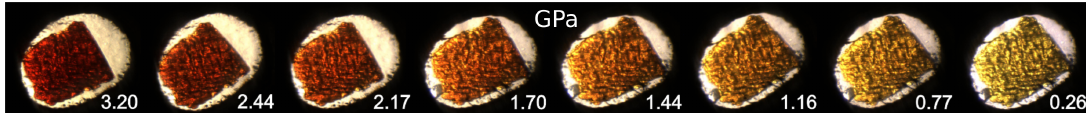
Figure 8. Microscopy images of a 1a crystal in a Diamond Anvil Cell (DAC) (gasket diameter ≈ 400 µ m, a small ruby chip is visible at the lower-left corner). Gradual darkening of the sample with pressure indicates a red-shift in the UV-Vis absorption spectrum. The crystal has been cycled from low to high pressure and back several (six) times, with repeatable results.